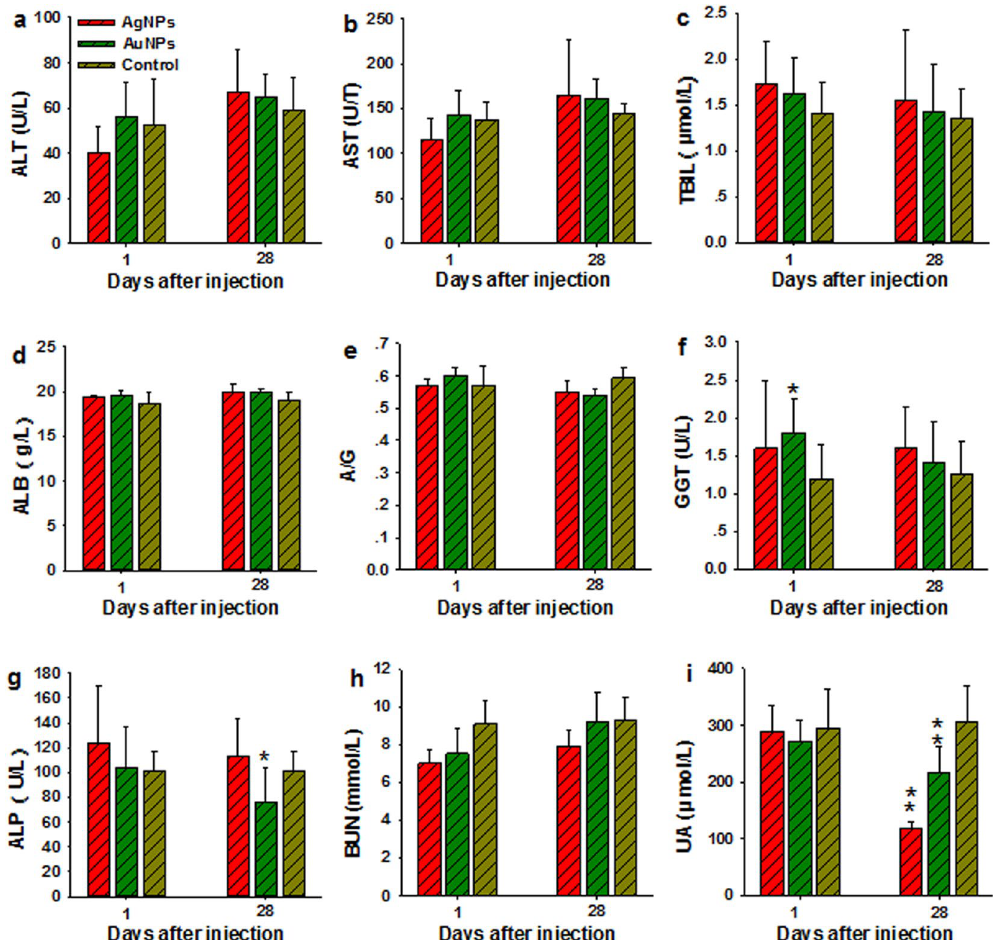
Figure 4. Serum biochemical analysis from animals treated with AgNPs and/or AuNPs and control. ( a–i ) Results exhibit mean and standard deviation of ALT ( a ), AST ( b ), TBIL ( c ), ALB ( d ), A/G ( e ), GGT ( f ), ALP ( g ), BUN ( h ), and UA ( i ). Abbreviations: alanine aminotransferase, ALT; aspartate aminotransferase, AST; total bilirubin, TBIL; albumin, ALB; the ratio of albumin to globulin, A/G; gamma glutamyl transaminase, GGT; alkaline phosphatase, ALP; blood urea nitrogen, BUN; and urea, UA, n =